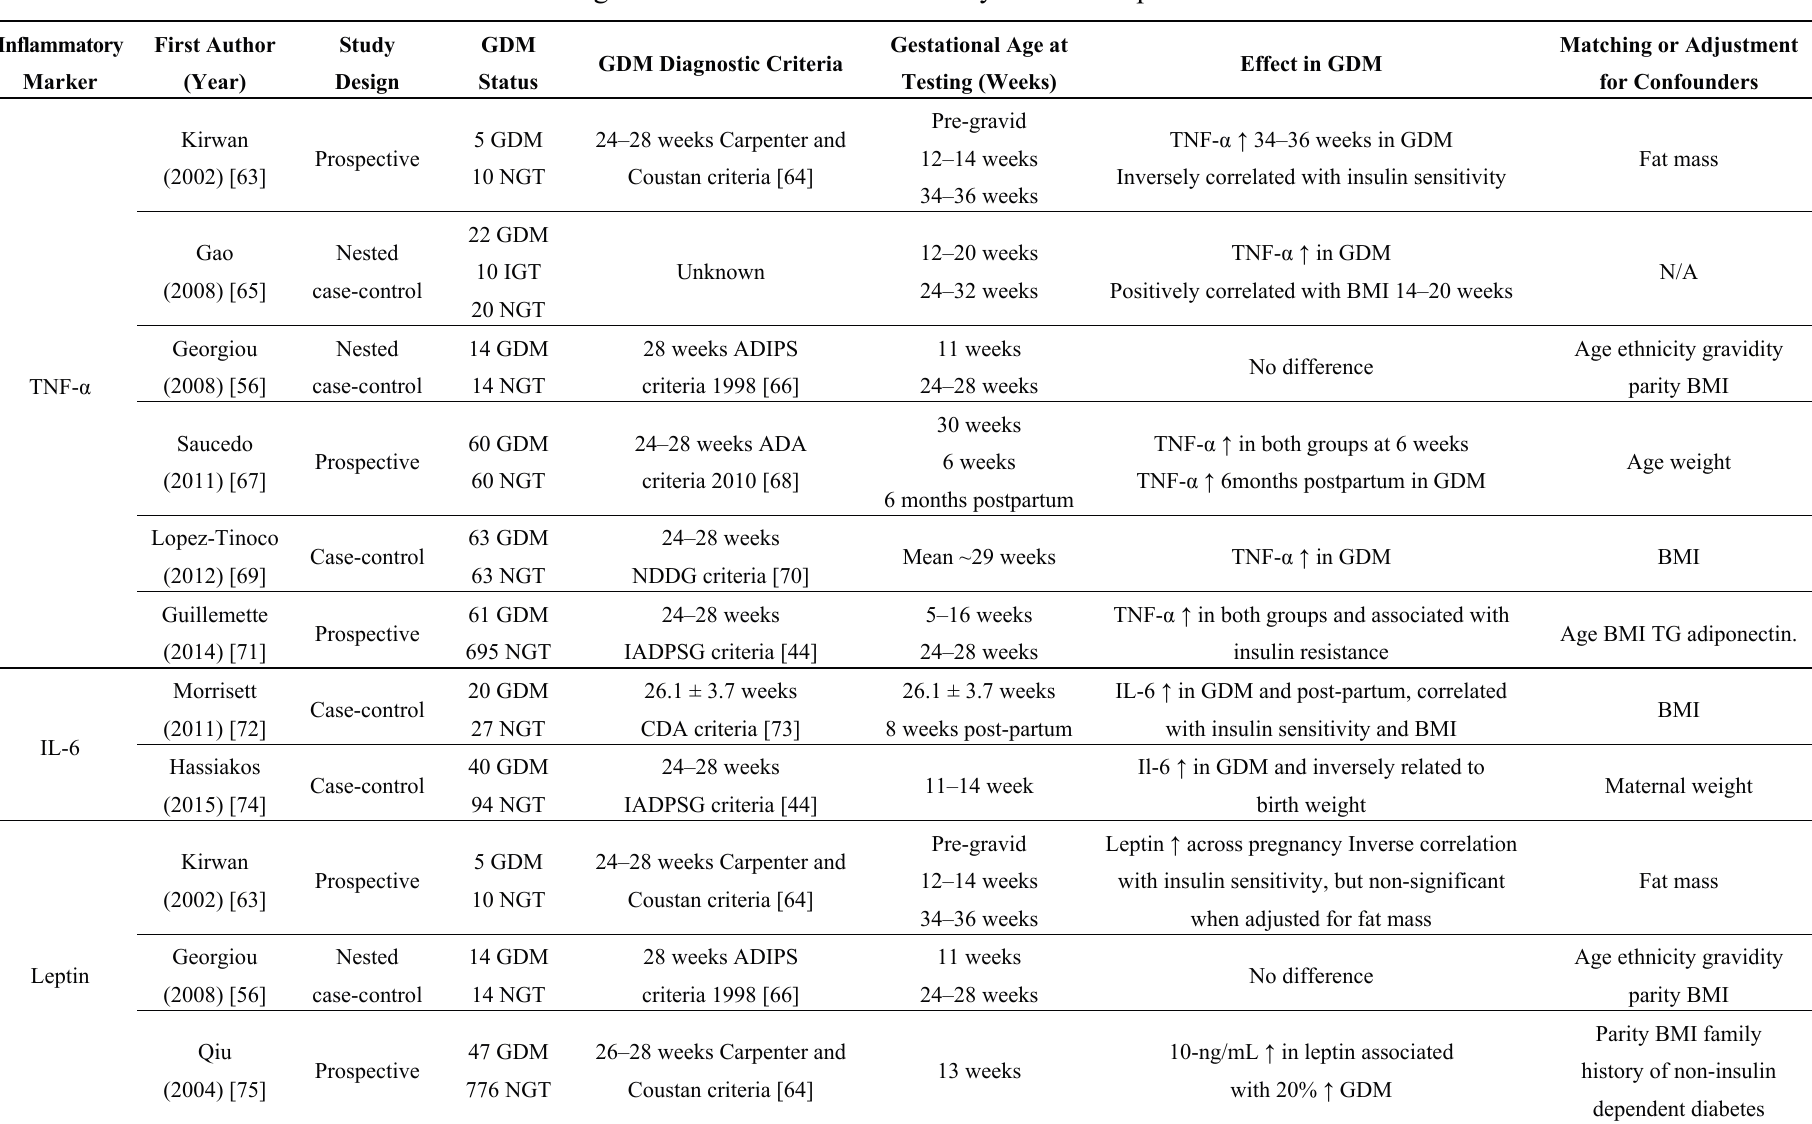
Table 1. Longitudinal studies of inflammatory markers in prediction of